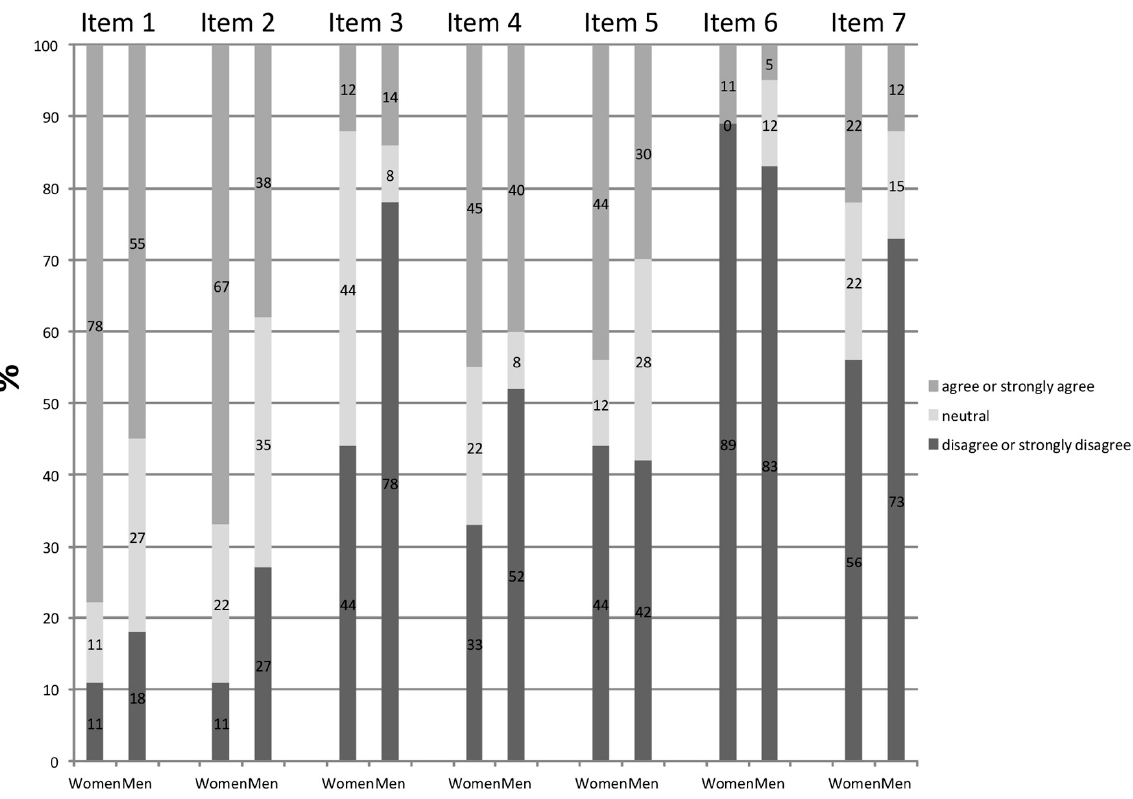
Figure 2. Histograms reporting the % answers corresponding to score 1 and 2 (“strongly disagree” or “disagree”), 3 (“neutral”), or 4 and 5 (“agree” and “strongly agree”) in STEMI female and male patients.